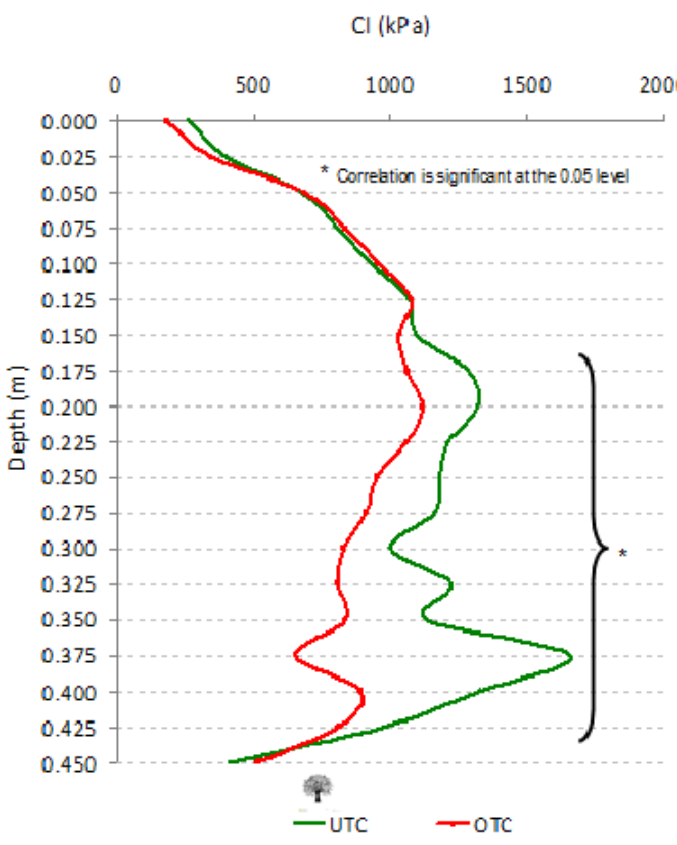
Figure 10. Average cone index (CI) under tree canopy (UTC) and outside tree canopy (OTC), in the 0-0.45m soil layer. *—Correlation is significant at the 0.05 level.